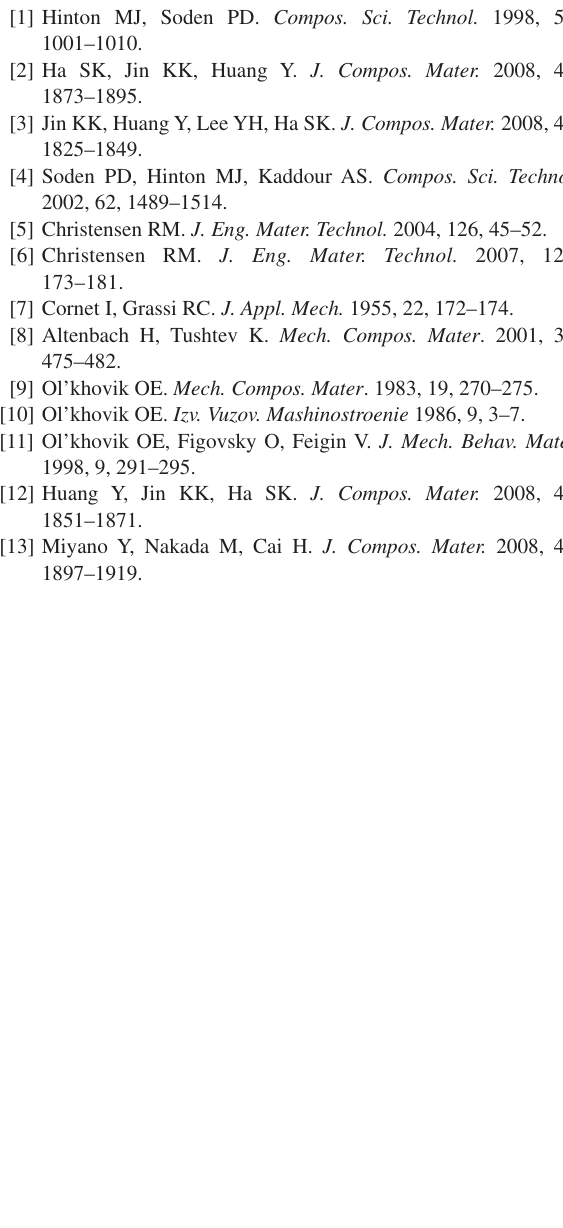
= 6 at different life / σ 1 2